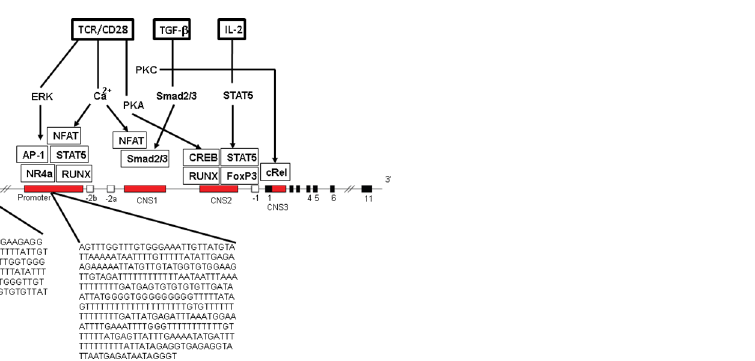
Fig 1. Molecules involved in FOXP3 induction and stable expression and sequences analyzed. Enhancer (5 ’ upstream enhancer, conserved non-coding sequences, CNS1, CNS2 and CNS3 serving as enhancer regions) and promoter region are shown (modified after 36,37,68]. Promoter and enhancer regions are bound by several transcription factors and signals. A restriction in differentiation of nTregs is caused by protein inhibitor of the activated signal transducer and activator of transcription STAT1 which binds to the FOXP3 promoter and recruits DNA methyltransferase [68]. CNS1, an intronic enhancer (enhancer 1)